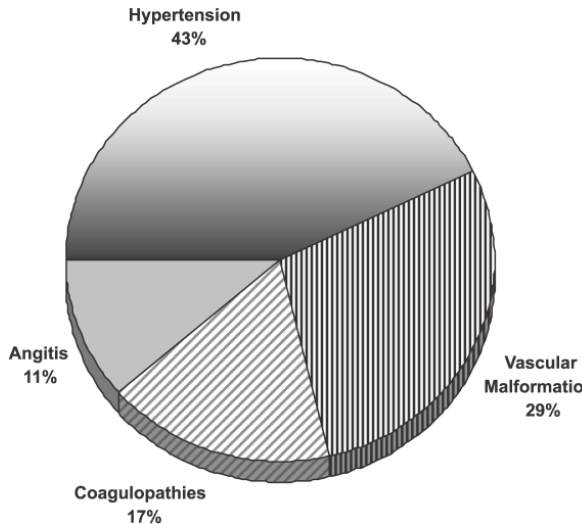
Figure 2 - Causes of Hemorrhagic Stroke in Young